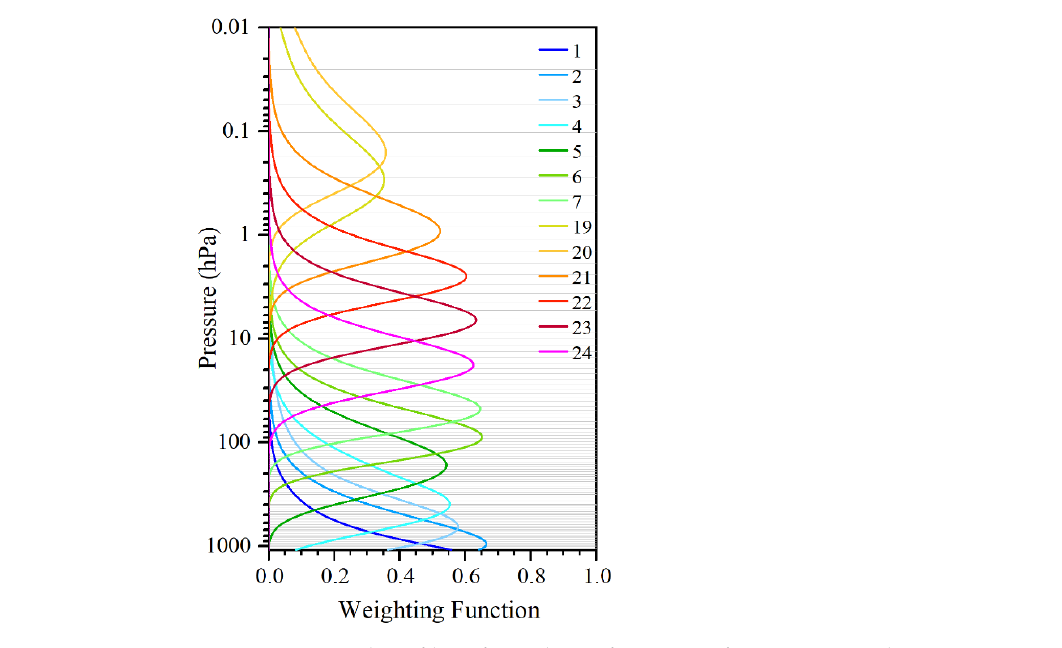
Figure 1. Vertical profiles of weighting functions of SSMIS atmospheric temperature sounding channels, which are calculated from the US standard atmosphere profile using Community Radiative Transfer Model (CRTM, version 2.3.0).